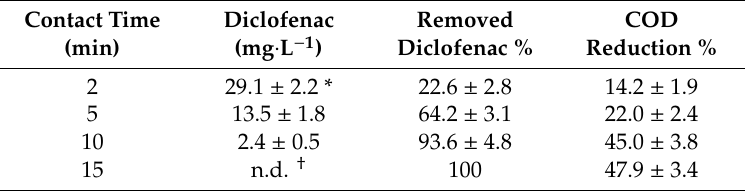
Table 5. Ultraviolet radiation treatment combined with sodium hypochlorite (5 mg · L − 1 ).